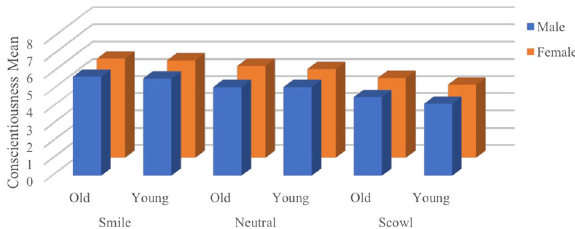
Fig. 10 Facial expression and Conscientiousness. This graph presents interaction of facial expression, age, and gender on mean ratings of